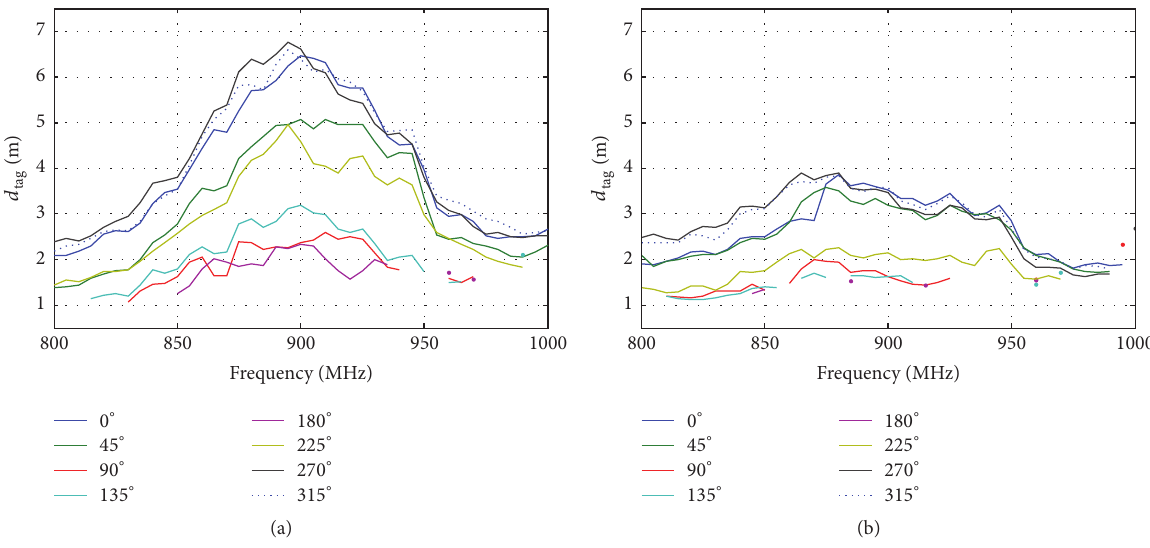
Figure 9: Measured attainable read range of the copper tape (a) and e-textile (b) tags attached to